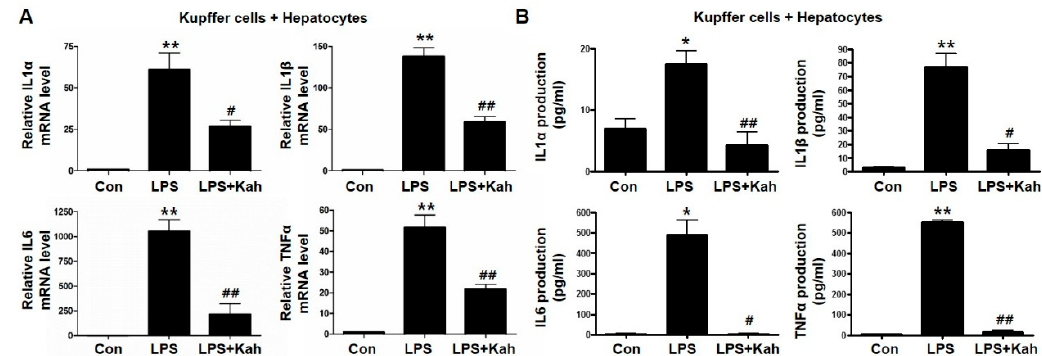
Figure 3. Effect of kahweol on lipopolysaccharide (LPS)-induced expression and production of IL1 α , IL1 β , IL6, and TNF α in primary Kupffer cell (KC) and primary hepatocyte (HC) co-culture. ( A ) Representative real-time RT-PCR analysis of IL1 α , IL1 β , IL6, and TNF α mRNA expression in co-culture of primary KC with primary HC. Data in the bar graph are mean ± SEM of three independent measurements. ** p < 0.01 compared with control (Con), # p < 0.05, ## p < 0.01 compared with LPS. ( B ) Primary KC and primary HC co-cultures media were collected after LPS and kahweol (kah) treatment, the production of IL1 α , IL1 β , IL6, and TNF α were measured using the ELISA kits. Data in the bar graph are mean ± SEM of three independent measurements. * p < 0.05, ** p < 0.01 compared with control (Con), # p < 0.05, ## p < 0.01 compared with LPS.